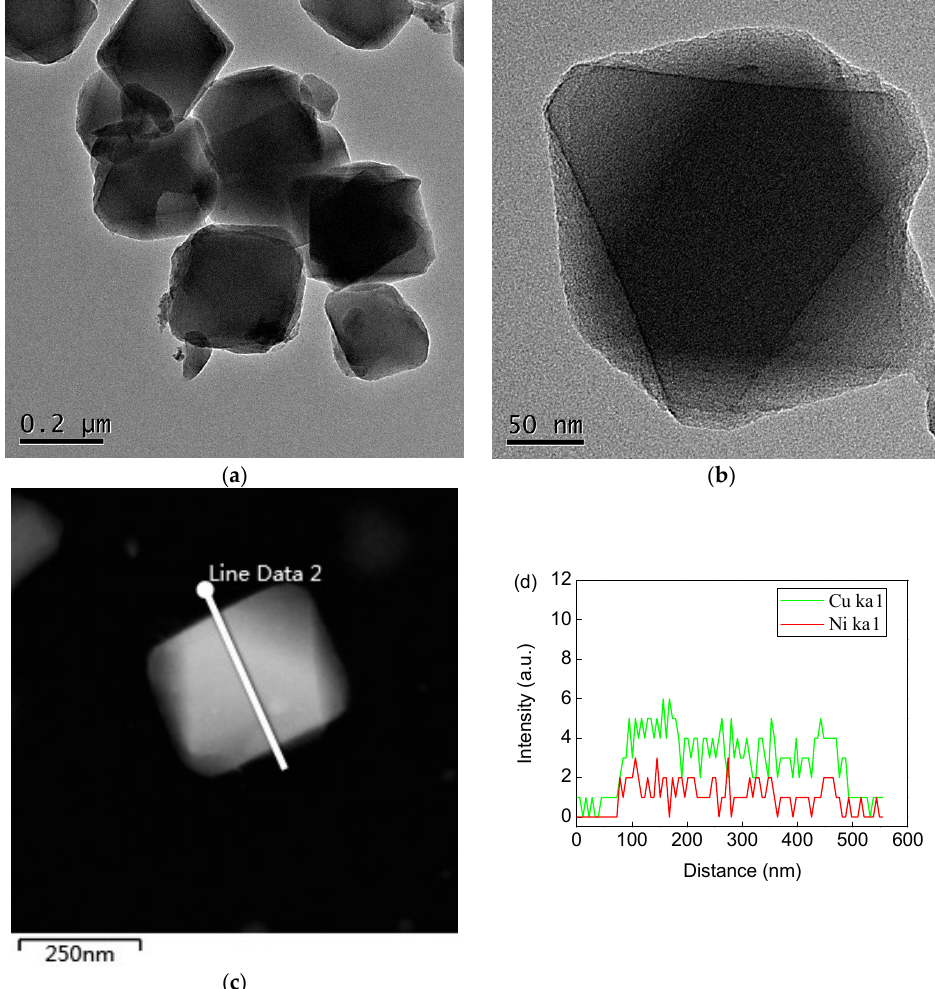
Figure 5. TEM images ( a – c ) and EDS line-scanning profile analysis of typical nanoparticles indicated by the white line in ( c ) for CuNi / MIL-101 ( d ). Catalysts 2019 , 9 , x FOR PEER REVIEW